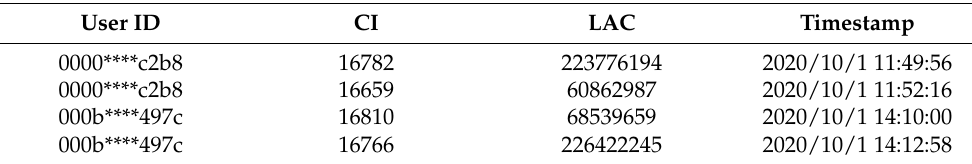
Table 1. Example of raw records of mobile tracking